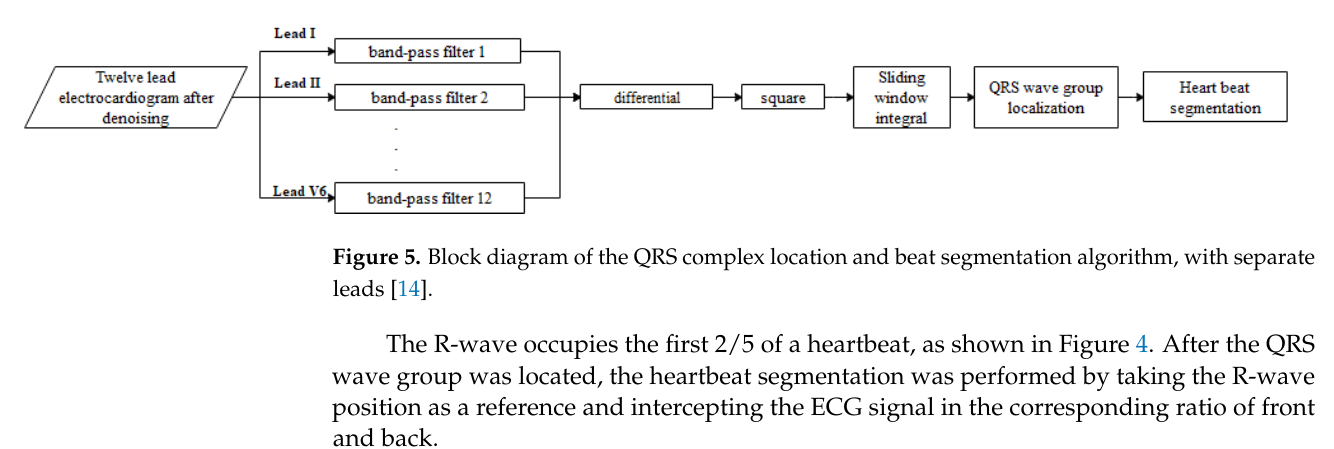
Figure 4. Schematic diagram of a standard heartbeat.